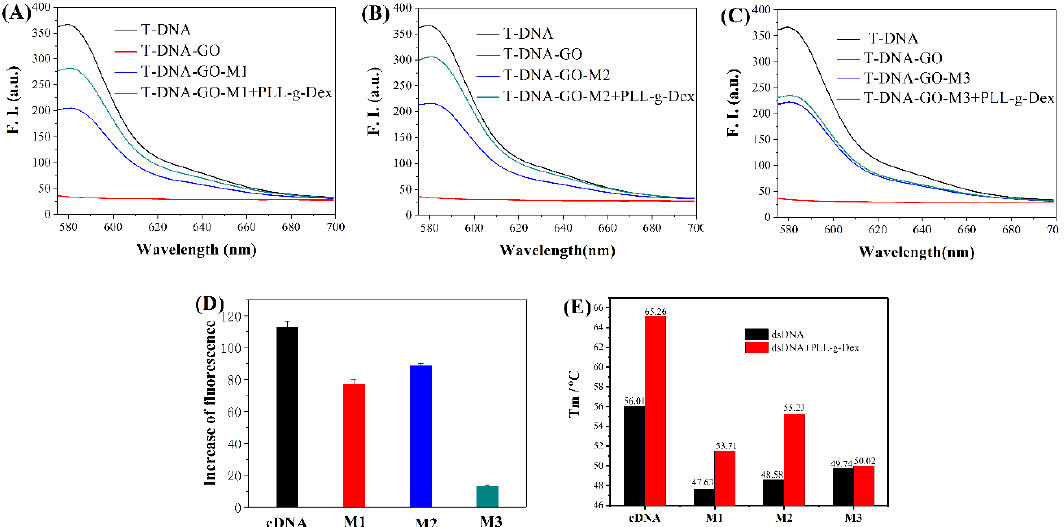
Figure 4. ( A – C ) The fluorescence intensity of target chains with different mismatched bases. ( D ) The increase of fluorescent intensity at 582 nm in the presence of PLL- g -Dex, compared with the fluorescent intensity at 582 nm without PLL- g -Dex. ( E ) T m of different double-strands DNA without (black) or with (red) PLL- g -Dex. [GO (9 µ g/mL), cDNA, M1, M2, or M3 (90 nM), PLL- g -Dex (96 nM)]. Table 2. T m of different double-strands DNA without or with PLL- g -Dex. Double-Strands DNA